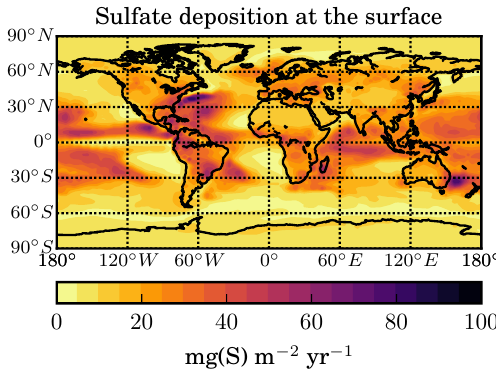
Figure 16. Annual mean deposition rate of sulfate aerosol of strato- spheric origin at the Earth’s surface (in mgSm − 2 yr − 1 ) in the STANDARD scenario.